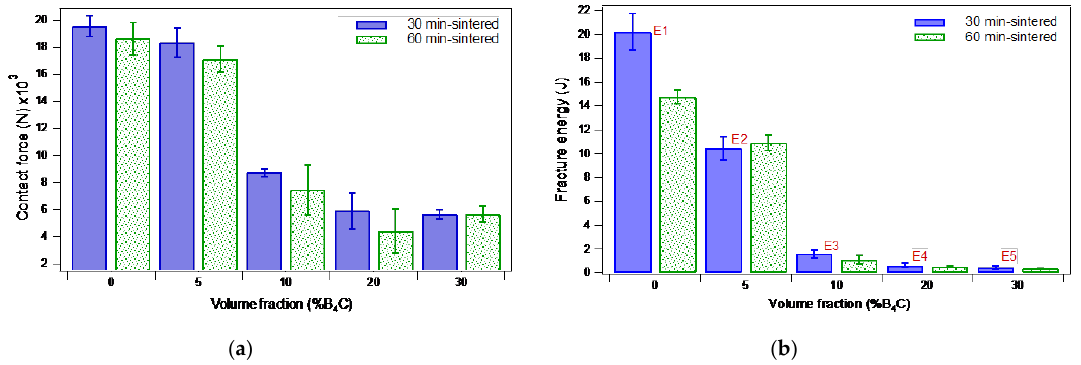
Figure 16. Comparison of 60 min sintered test specimens for: ( a ) contact force−time (F−t); ( b ) energy−time (E−t) curves of impactor; the inset is a magnification of the region indicated by the red dashed line.